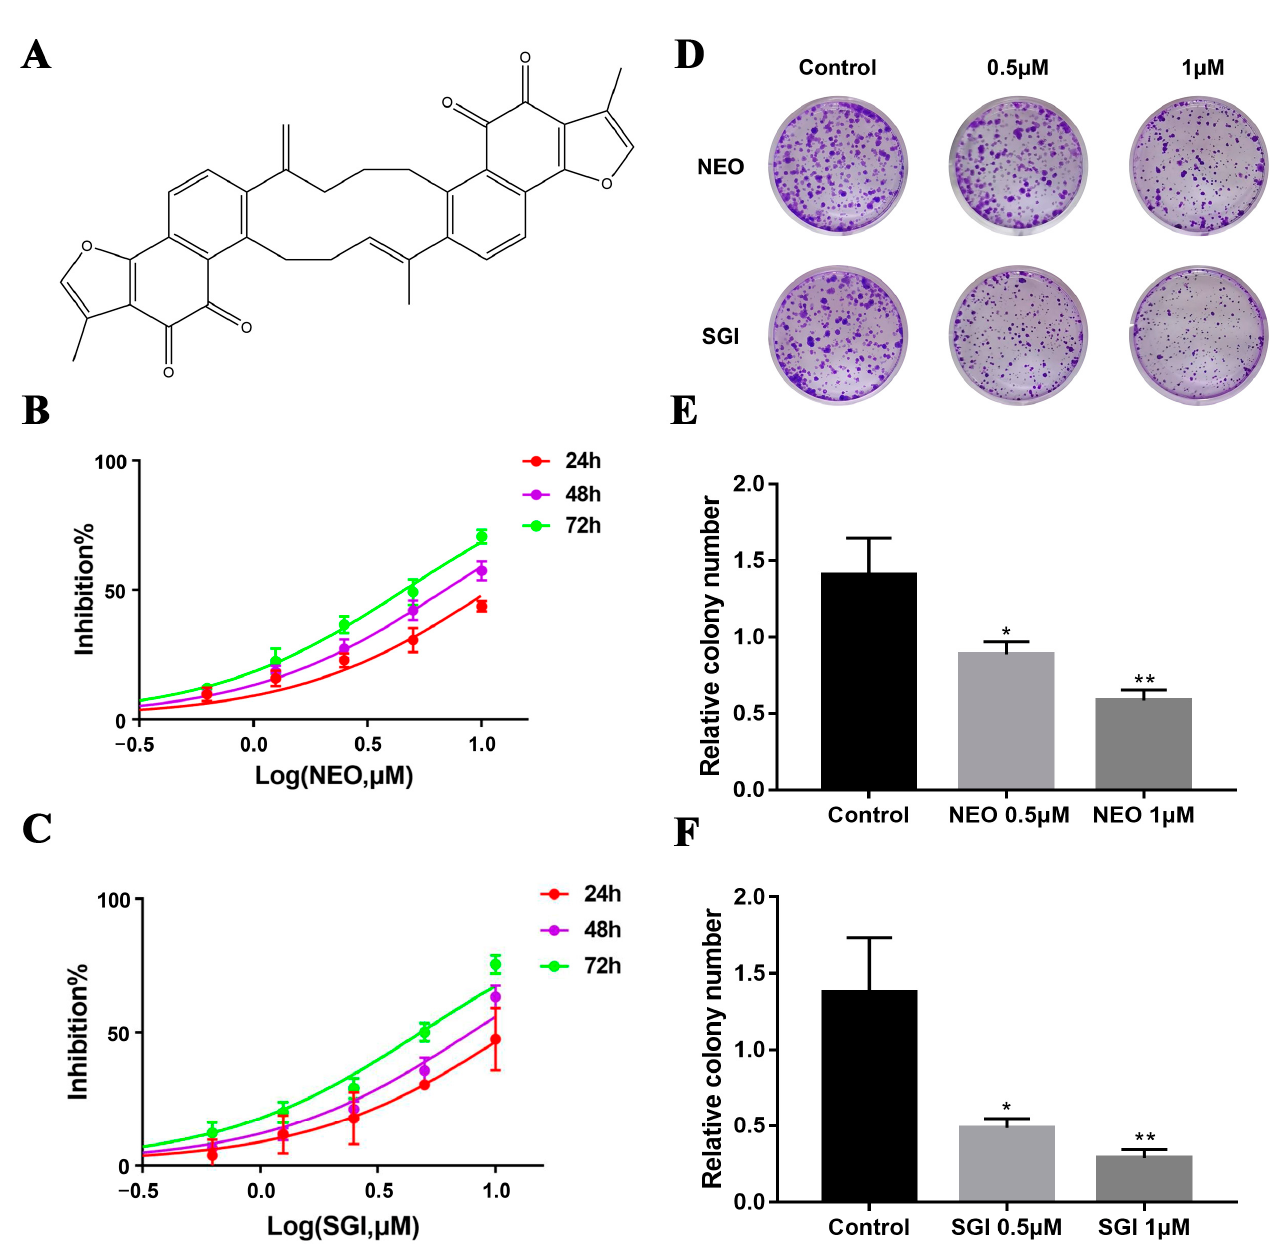
Figure 1. The structure of NEO and inhibitory effect of NEO on the proliferation of MDA-MB-231 cells. ( A ) Molecular structure of NEO. ( B , C ) Effects of NEO and SGI-1776 on the proliferation of MDA-MB-231 cells. ( D ) Representative images of MDA-MB-231 cell colonies treated with different concentrations (0, 0.5 and 1 µ M) of NEO and SGI-1776. ( E , F ) The growth of cancer cell-derived colonies from MDA-MB-231 cells was assessed by determining the number of colonies after NEO and SGI-1776 (0, 0.5 and 1 µ M) treatments for 7 days. Each value is the mean ± SD for n = 3. * p < 0.05, ** p < 0.01 versus the control group.